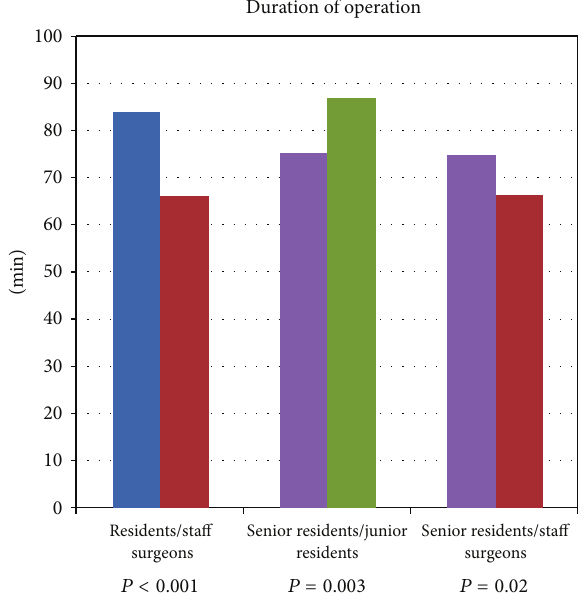
Figure 1: Duration of operation in minutes of elective laparoscopic cholecystectomy in residents versus staff surgeons, senior residents versus junior residents, and senior residents versus staff